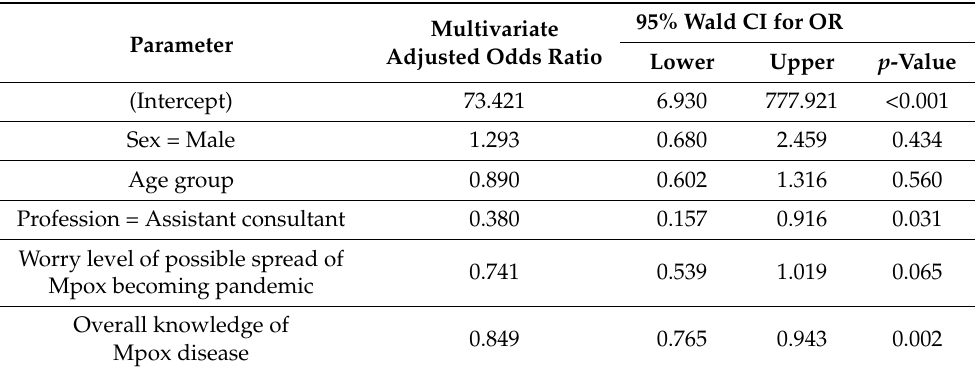
Table 7. Multivariable binary logistic regression of variables associated with participants’ awareness of Mpox and COVID-19 clinical presentation (n =